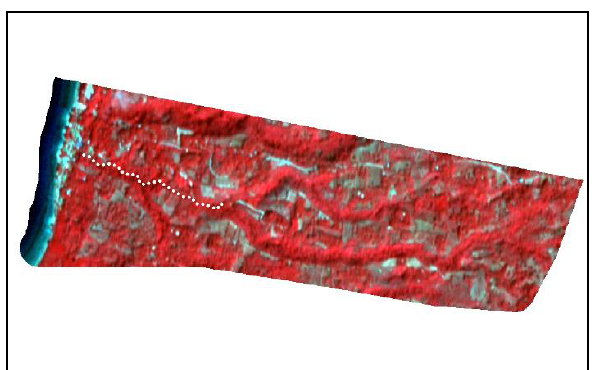
Figure 2. Landsat false-color (4,3,2) composite of Tangbo River, 2019.